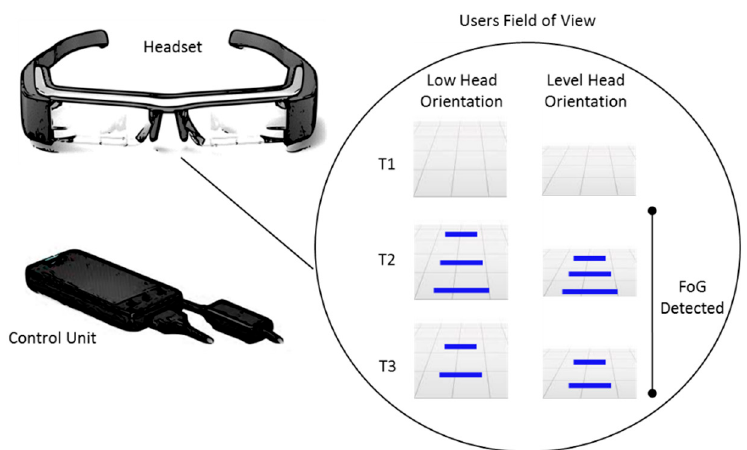
Figure 12. Visual stimuli system presented by Ahn et al. The system consisted of the Moverio BT-200 smart glasses (headset, a control unit and cables) and an android application that displayed parallel blue lines when FoG was detected (T2–T3). As illustrated, these lines move forward in sync to the user’s gait speed and head orientation. For example, as the user lowers their head (to look down) the distance between the lines